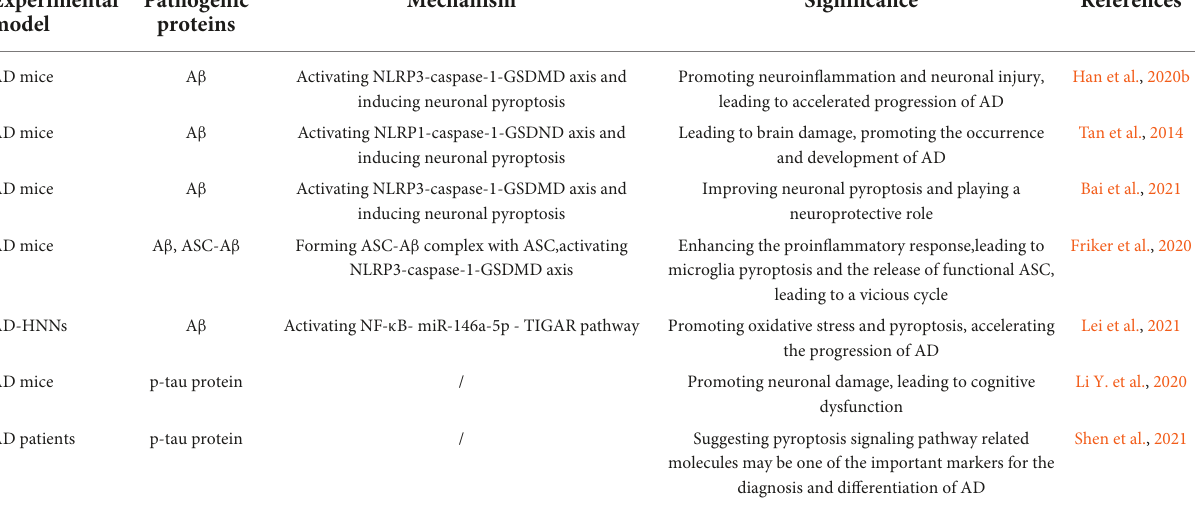
TABLE 1 AD-related injuries mediated by